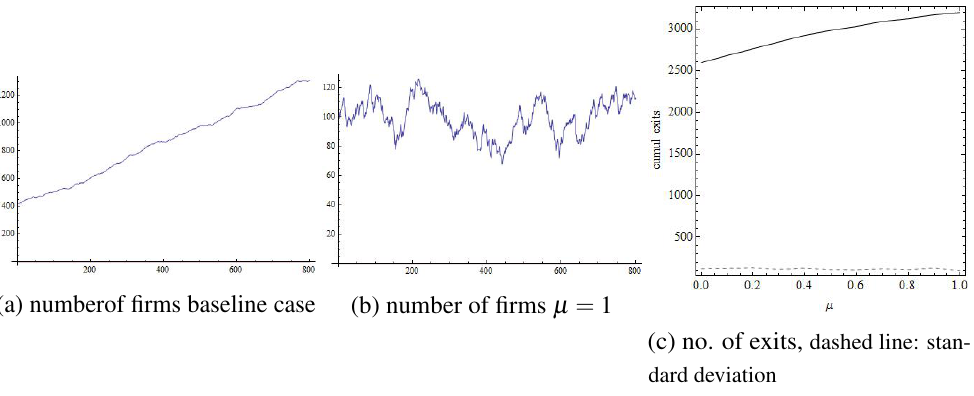
Figure 3: Impact of µ on the no. of